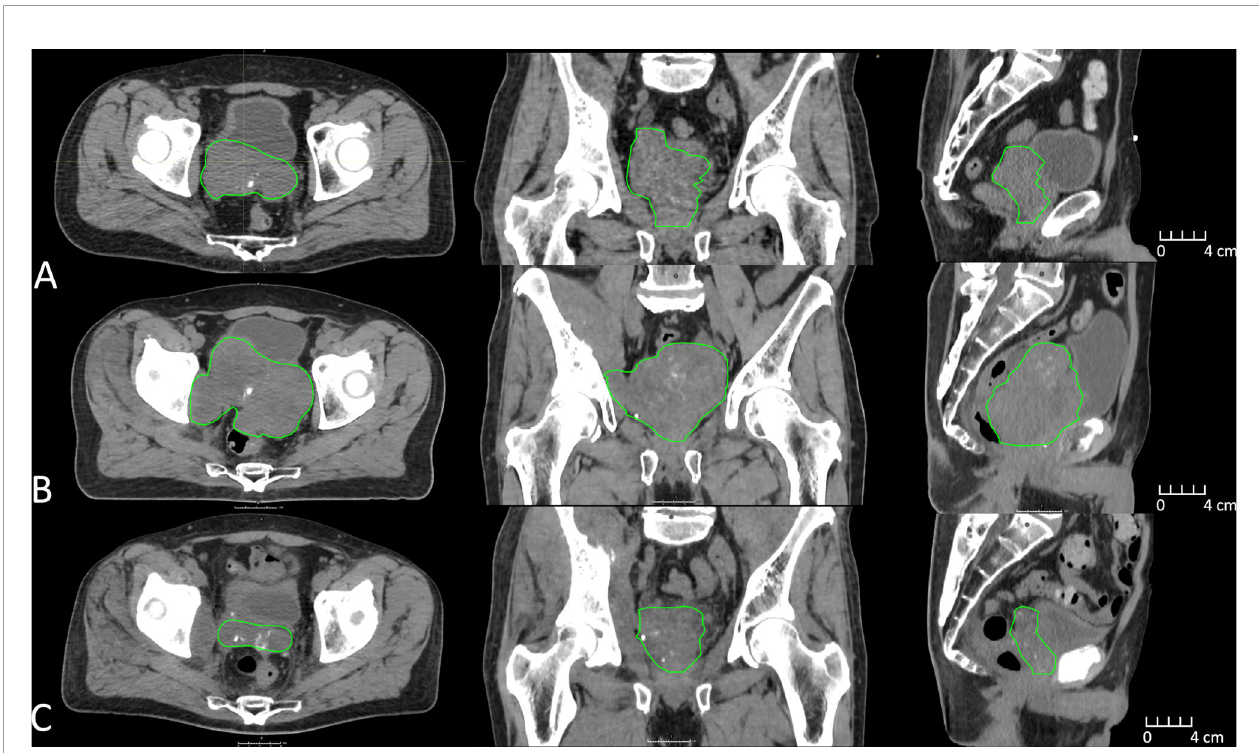
FIGURE 1 | CT imaging depicting clinical target volume (green) changes approximately 1 year prior to MR-Linac treatment (A) , immediately prior to MR-Linac treatment (B) , and 6 months post MR-Linac treatment (C)